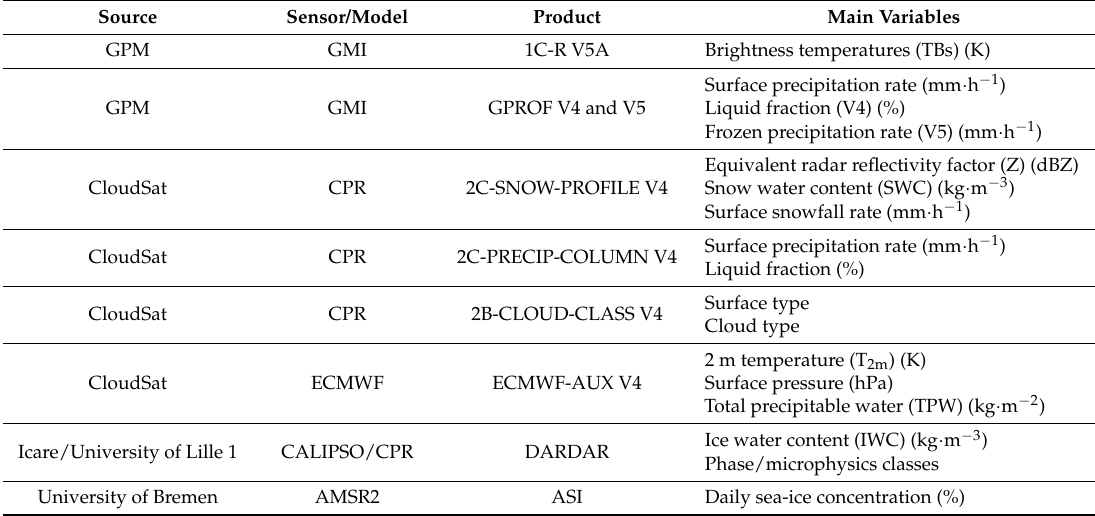
Table 1. List of products available in the dataset built from coincident GMI/CloudSat observations (10 March 2014–31 May 2016) and list of the main variables used in this